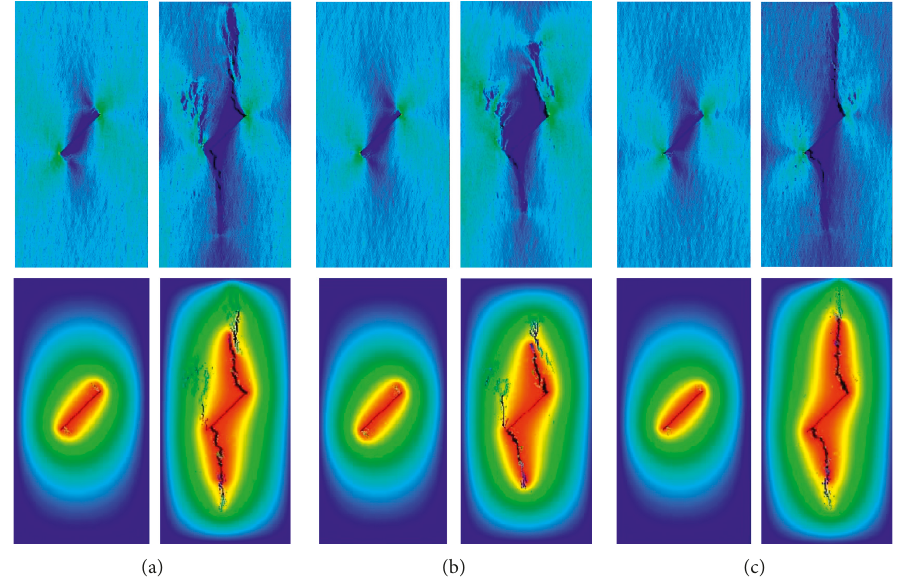
Figure 7: Maximum shear stress (upper) and pore pressure (lower) evolution diagram of different pore pressures when σ � 2.0MPa. (a) P � 1.0MPa, σ � 2.0MPa; (b) P � 1.5MPa, σ � 2.0MPa; (c) P � 1.8MPa, σ �